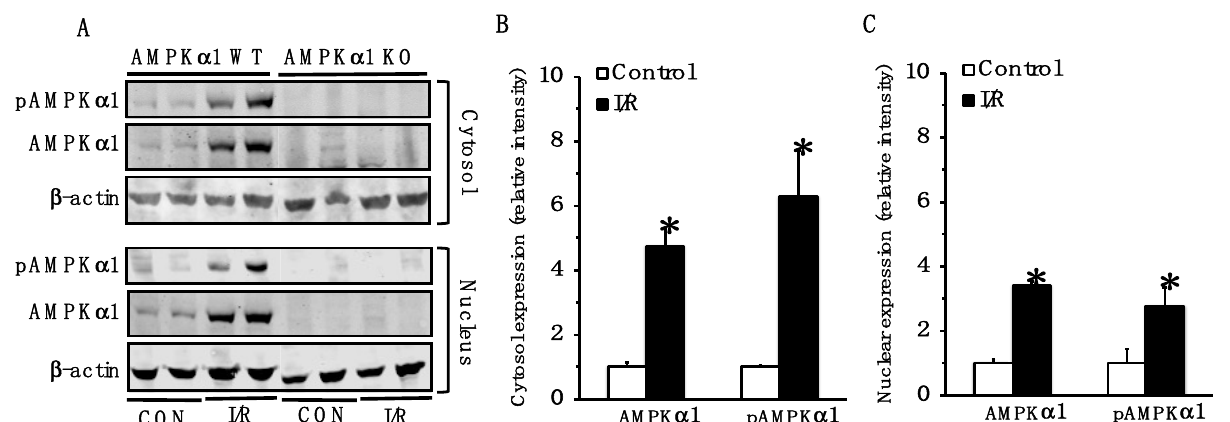
Figure 1. Representative Western blot analysis of pAMPK α 1, AMPK α 1, and β -actin (used as loading control protein) in small intestine cytosol and nuclear extracts at basal control conditions (CON) and at 4 h after mesenteric ischemia and reperfusion (I/R). ( A ). Quantitative analyses of AMPK α 1 and pAMPK α 1 expression as determined by densitometry in the cytosol ( B ) and in the nucleus ( C ). Data are mean ± SEM of 3 control mice and 4 mice subjected to I/R injury. Data are expressed as relative intensity units; * p < 0.05 versus control mice.